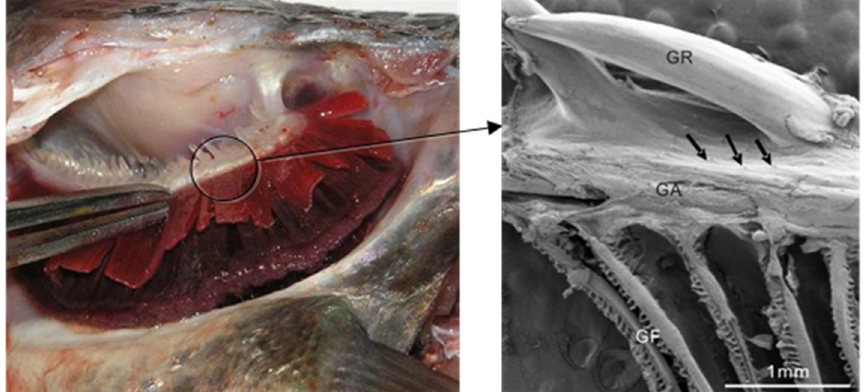
Figure 1. Gill morphology in carp (cyprinus carpio): left, photo of a carp gill; right, close-up (GR: gill rakes; GA: gill arches; GF: gill